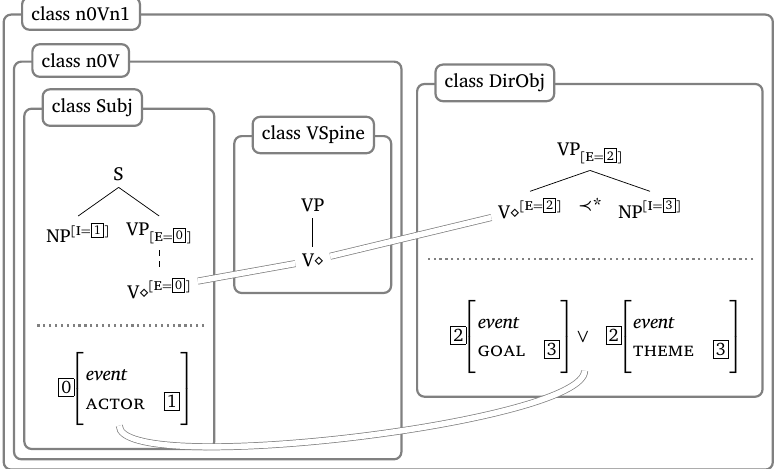
Figure 5: Metagrammatical factorization for the transitive elementary